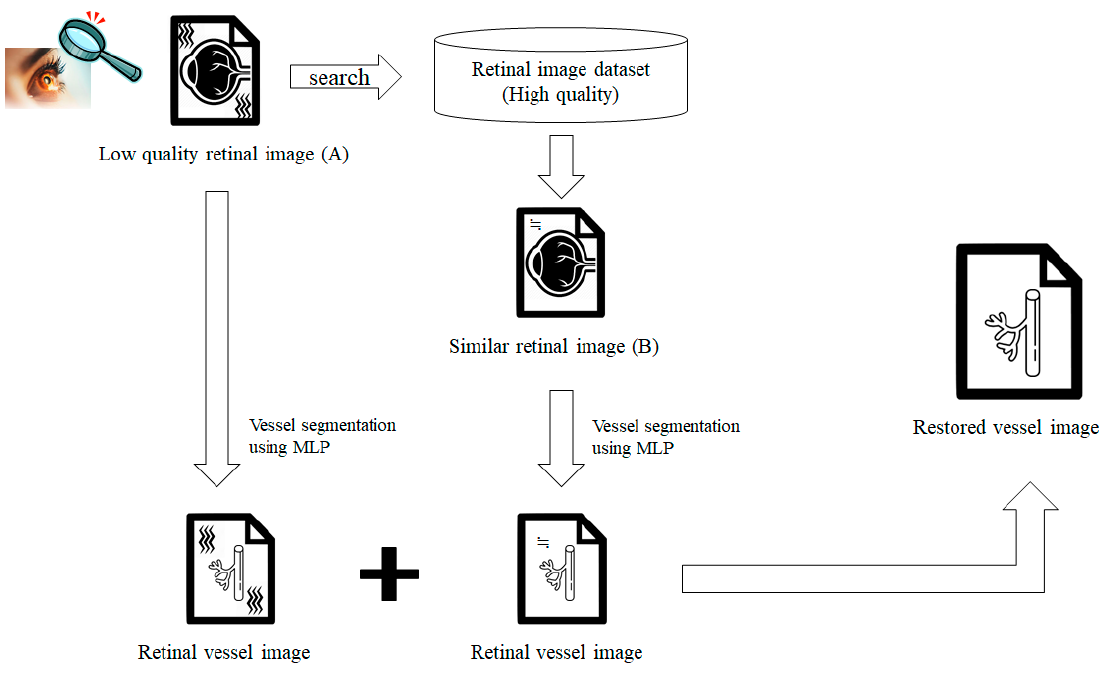
Figure 6. Overall Figure 6. Overall approach.